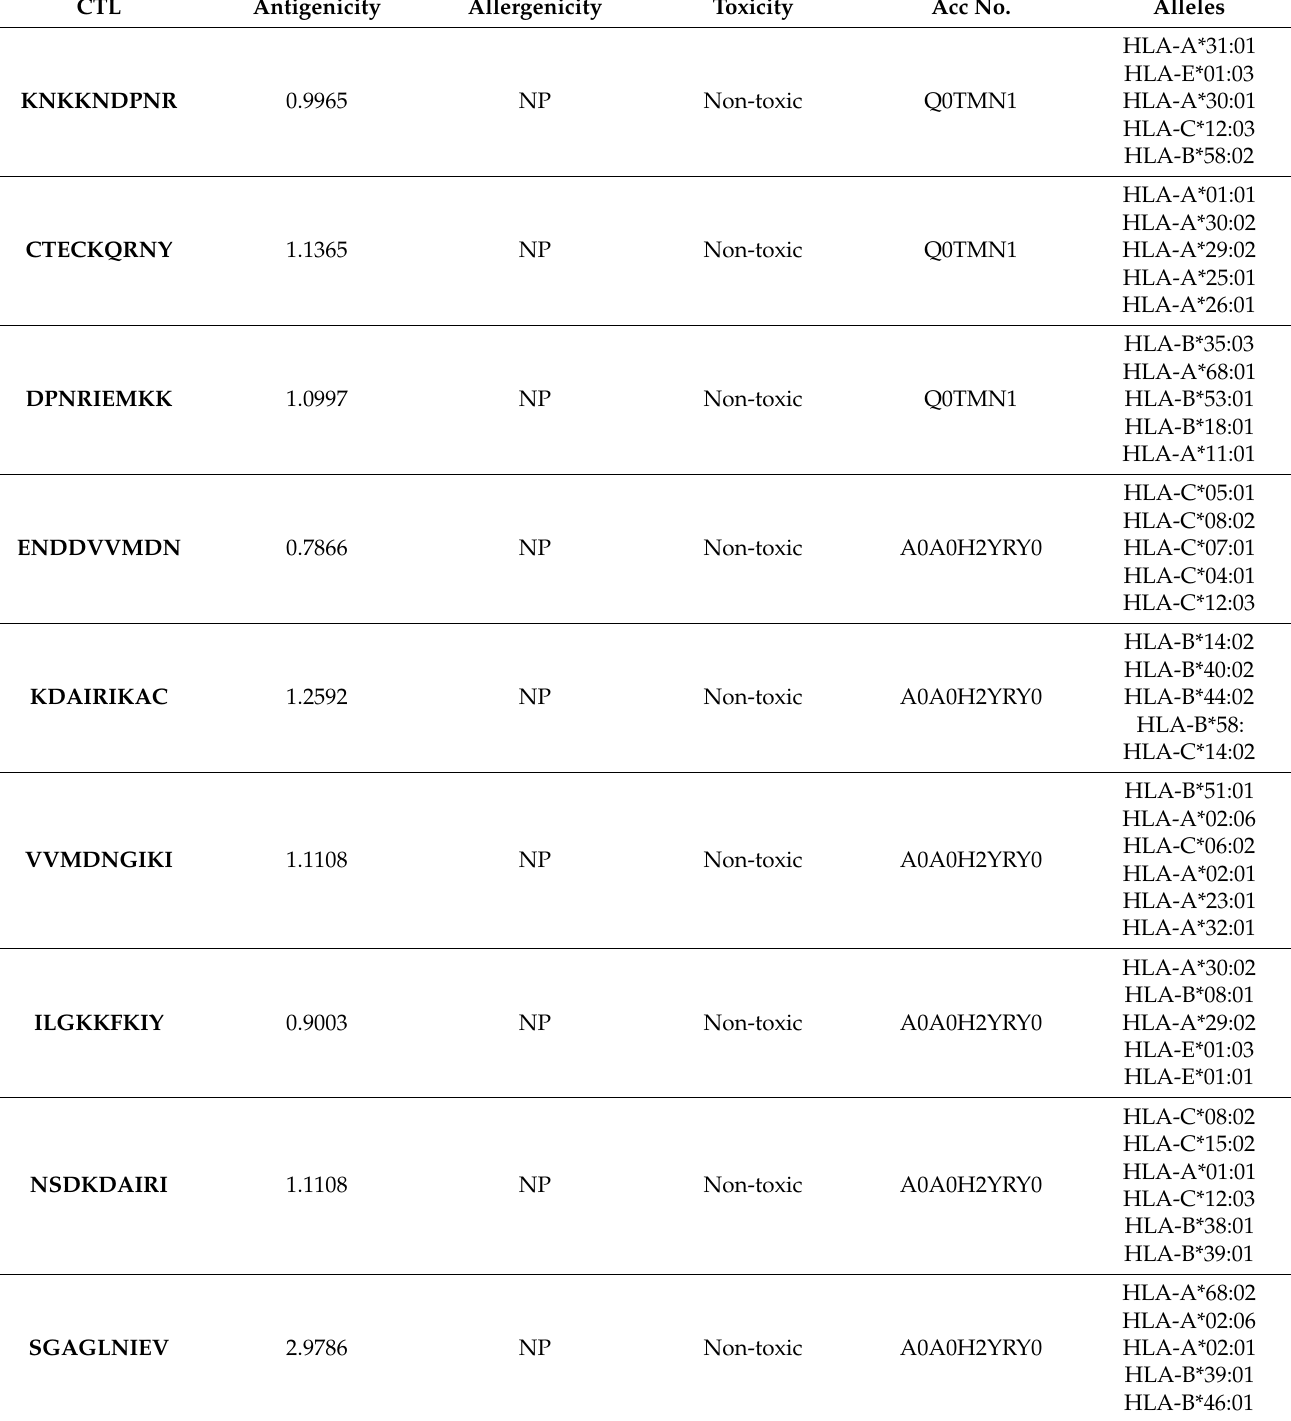
(Table 3). Furthermore, the forecasted epitopes of B-cells were screened through ToxinPred, AllergenFP v.1.0, and VaxiJen for the evaluation of toxicity, allergenicity, and antigenicity, respectively [22,27,35]. Table 1. CTL selected for MEV